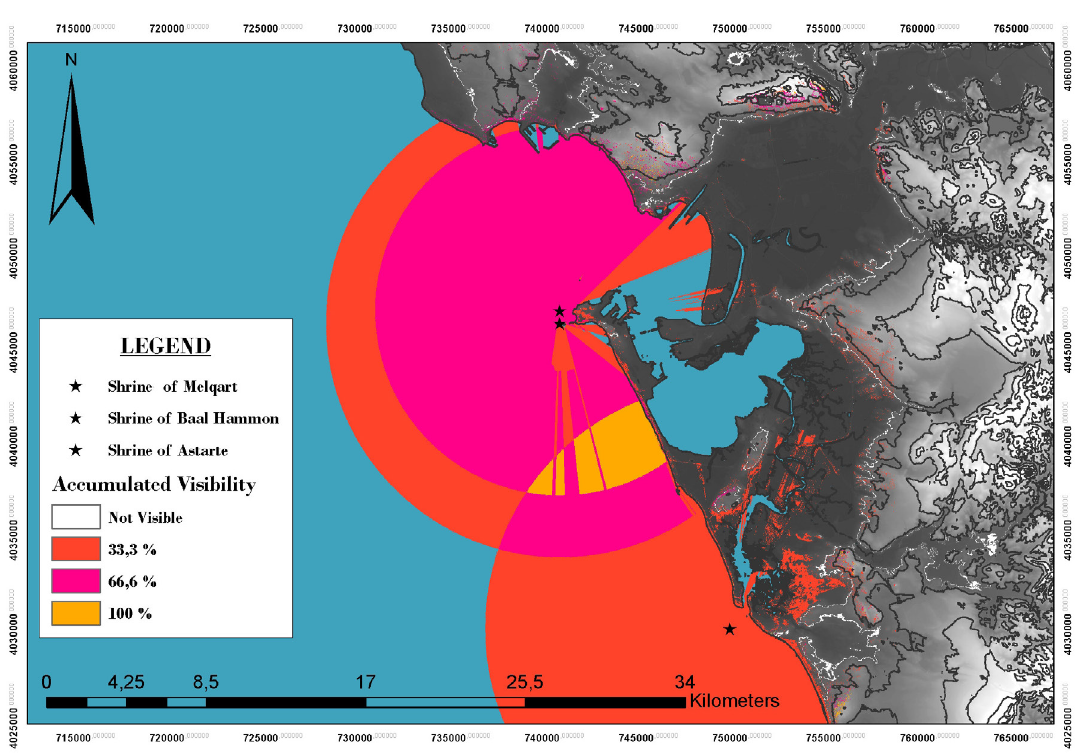
Figure 20. Representation of the analysis of visual association between the three shrines. Their visual control over the main- land and the sea can be observed.